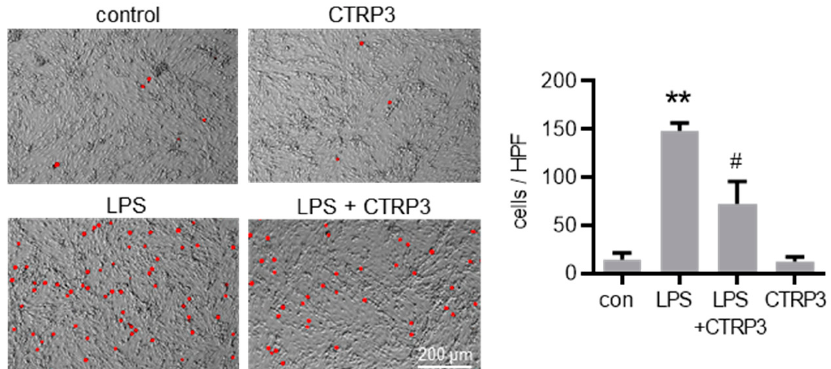
Figure 5. CTRP3 inhibits LPS-induced adhesion of monocytic cells on endothelial cells. Fluorescence cence images depicting calcein-AM-labeled J774A.1 cells on a MyEnd (myocardial endothelial) cell monolayer stimulated with LPS (lipopolysaccharides, 50 ng/mL) alone or pretreated with CTRP3 (C1q/TNF-related protein 3, 10 µ g/mL, for 30 min) and with CTRP3 alone for 16 h with an additional